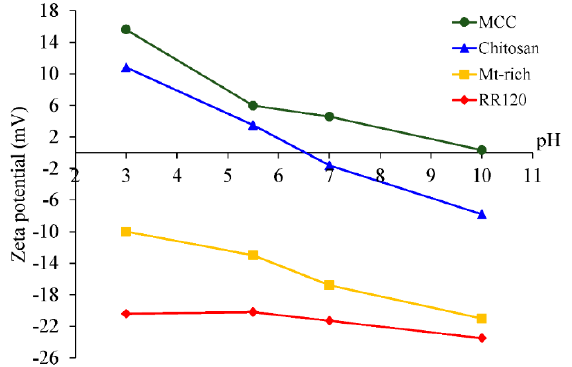
Figure 3. Zeta potential versus pH condition.